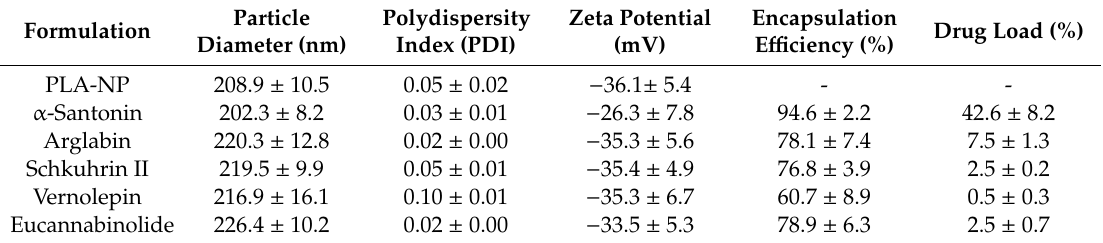
Table 1. Physicochemical characteristics of sesquiterpene lactone loaded polylactic acid nanoparticles (PLA-NPs) (mean ± S.D., n =